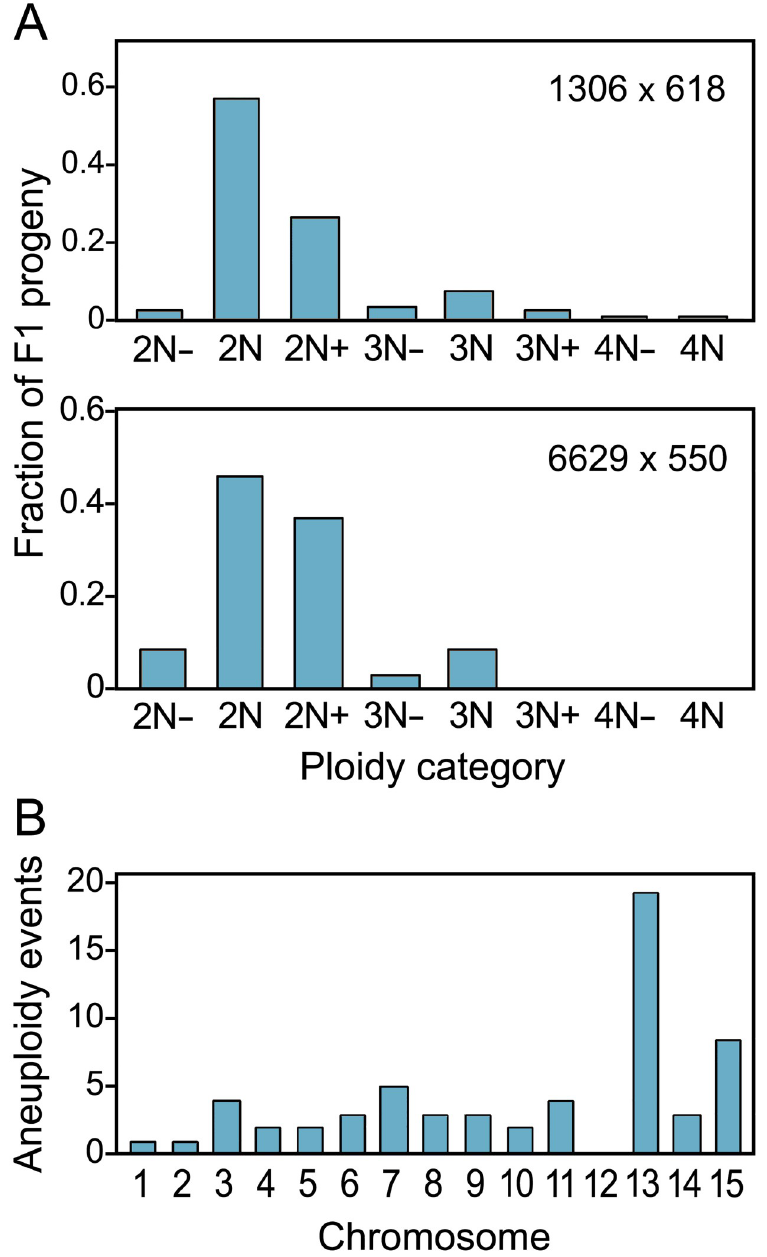
Fig 4. Frequency of euploid and aneuploid progeny. A , indicated for the two crosses are the relative ratios of diploid (2N) progeny, mostly diploid progeny that have chromosomal deficiencies (2N-) or excesses (2N+), triploids (3N) and their aneuploid variants (3N-, 3N+), and tetraploids (4N) and their aneuploid variants (4N-). Aneuploids are classified by whether they are closest to 2N, 3N, or 4N. B , Number of aneuploid events observed per chromosome.